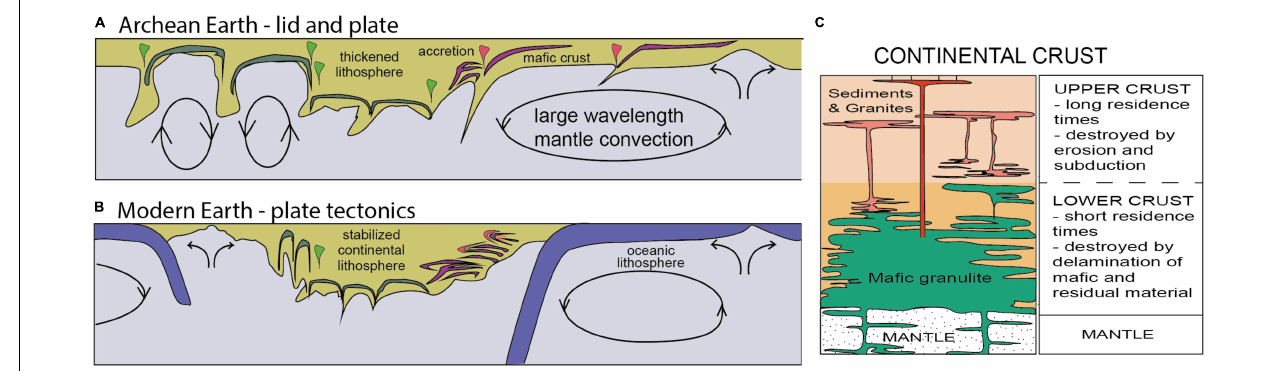
FIGURE 12 | Sketch of the early Earth evolution, based on the models of Capitanio et al. (2019b) that embed melting simulations in numerical models of large-scale mantle convection. (A) Transition from the Hadean, with relatively high rates of crust generation and recycling, to a lid-and-plate tectonics as a model for the Archean. This regime ended with the onset of the modern Earth’s plate tectonics regime (B) . (C) Schematic section of continental crust illustrating likely different residence times in the upper and lower crust.